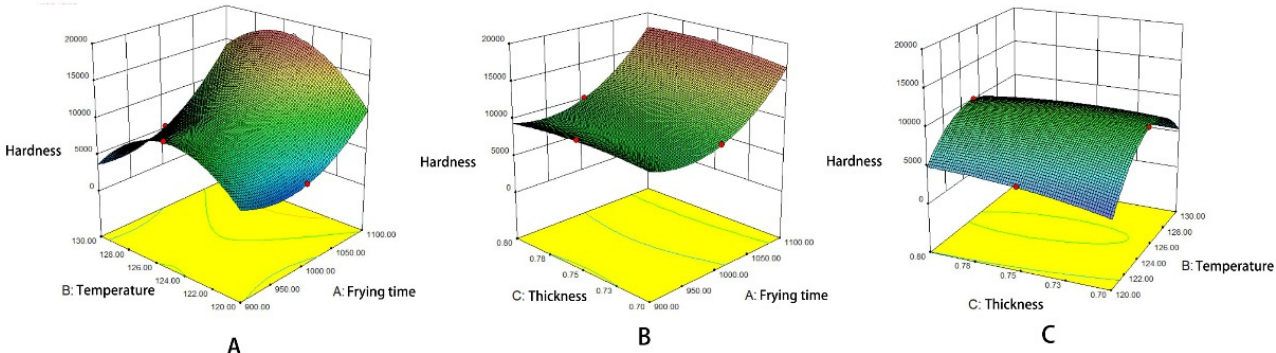
Figure 2. Response surface plots of interaction on the hardness ( R 1 ). ( A ) Temperature-Frying time, ( B ) Thickness-Frying time, ( C ) Thickness- Temperature.